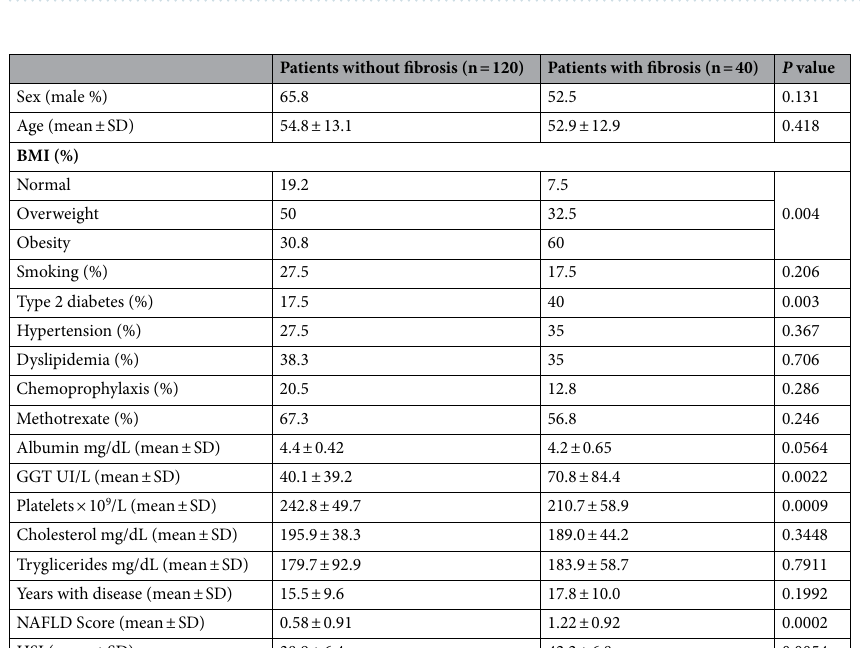
Figure 2. Study flow diagram.